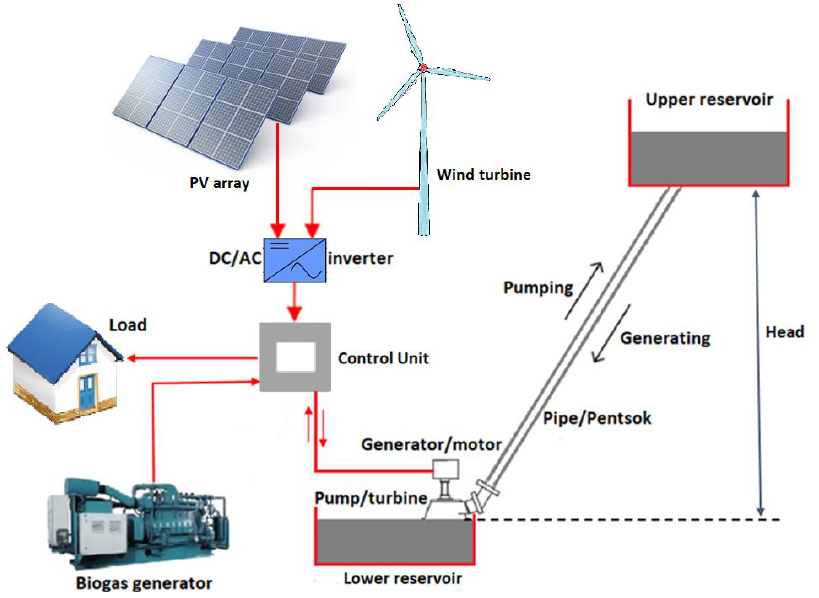
Figure 5. The schematic diagram of the hybrid renewable energy system.